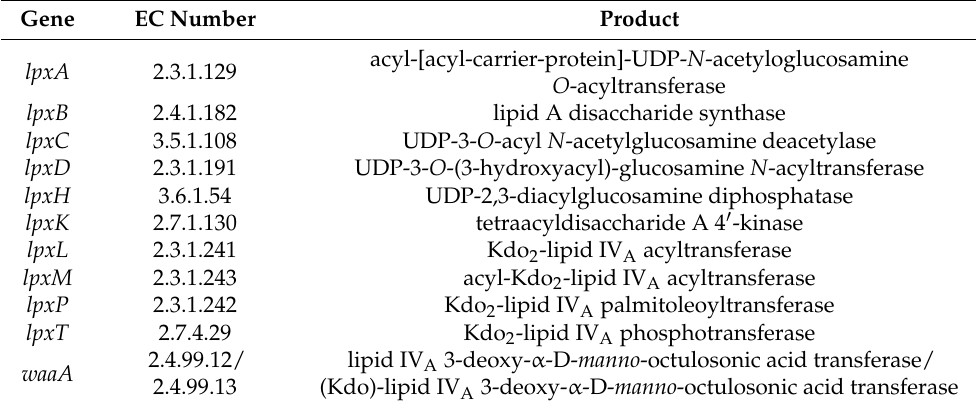
Table 1. Genes whose products are involved in Kdo 2 -lipid A